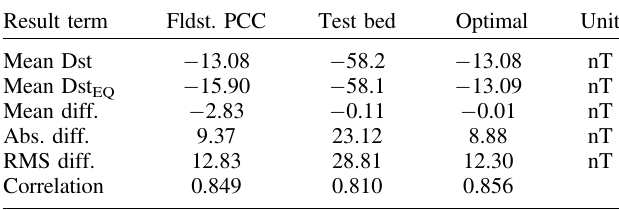
Table 4. Results from Dst EQ calculations.